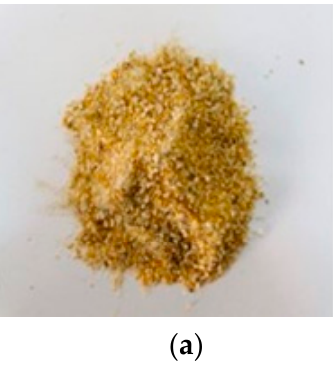
Figure 1. The materials used in the test. ( a ) Fujian standard sand, ( b ) Waste tire rubber particles, ( c ) Nanjing Yuhua cement.